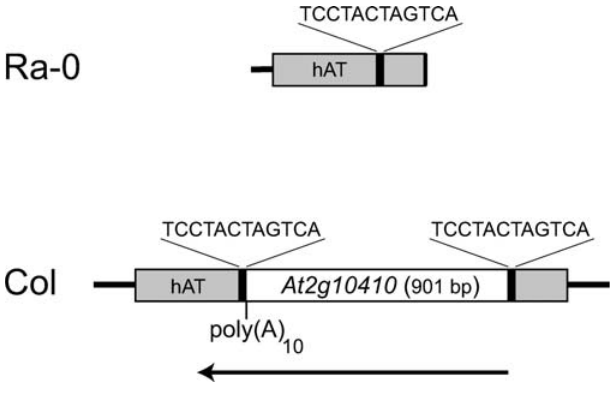
Figure 2. Structure of At2g10410 in Two Accessions At2g10410 in Col is inserted within a sequence that is 93% identical to a hAT10 (1536 to 2399 coordinates) DNA transposase gene (grey box, hAT). The poly(A) tract and target site duplication in Col are shown. The At2g10410 transcript is indicated by the arrow. The Ra-0 accession lacks the At2g10410 insertion, poly(A) tract, and target site duplication. DOI: